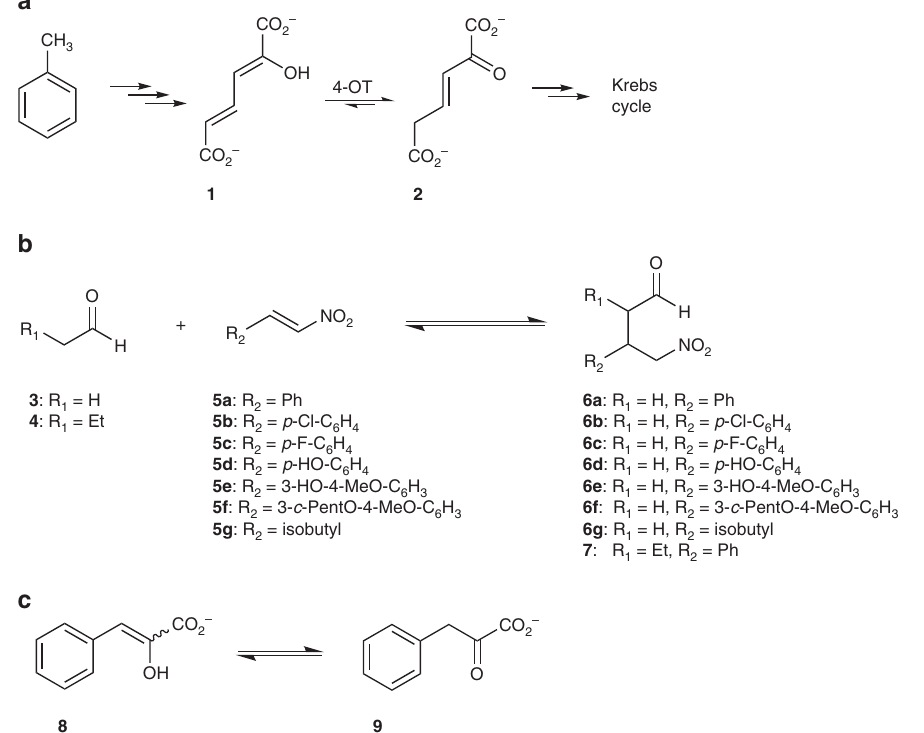
Figure 1 | Natural and promiscuous reactions catalysed by 4-OT. ( a ) 4-OT-catalysed tautomerization of 2-hydroxymuconate ( 1 ) to yield 2-oxohex-3- enedioate ( 2 ) as part of a degradative pathway for aromatic compounds. ( b ) 4-OT-catalysed Michael-type additions of acetaldehyde ( 3 ) or butanal ( 4 ) to nitroalkenes 5a – 5g to give g -nitroaldehydes 6a – 6g or 7 . ( c ) 4-OT-catalysed tautomerization of phenylenolpyruvate ( 8 ) to yield phenylpyruvate ( 9